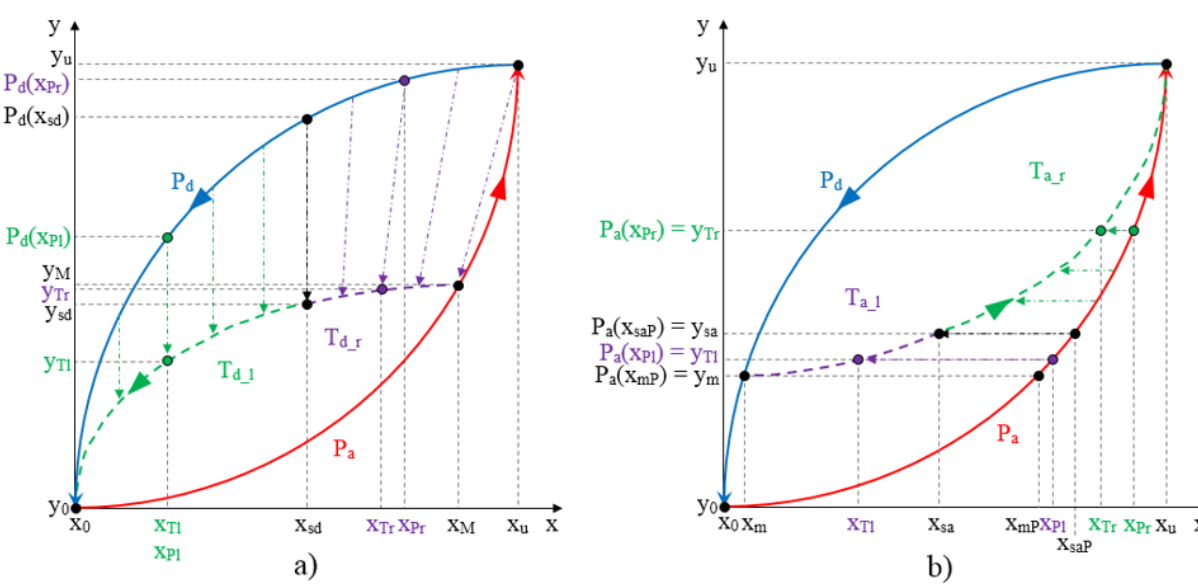
Figure 7. ( a ) Construction of descending curves for ELAM model; ( b ) Construction of ascending curves for ELAM